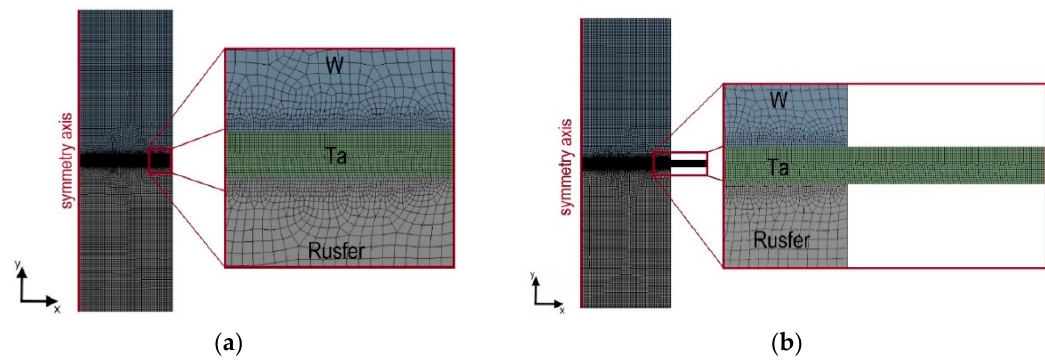
Figure 4. The mesh of the first ( a ) and second ( b ) models. Only the right halves of the symmetric assemblies are depicted. We modeled the process of cooling the assemblies from a joining temperature of 1100 °C to room temperature of 22 °C. Figure 5 shows the boundary conditions for modeling.